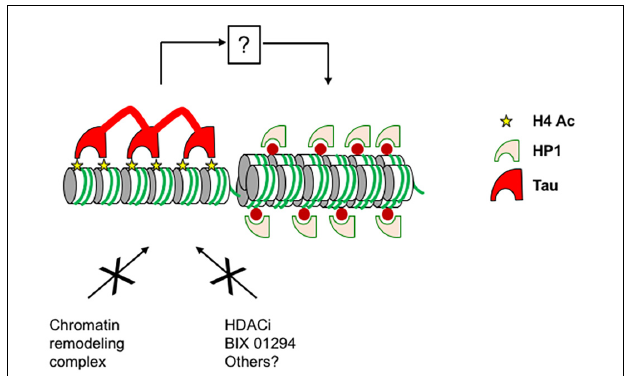
FIGURE 8 | Proposed model for the role of Tau on chromatin. Tau binds to condensed chromatin regions through the interaction with unmodified histone H3, H4, or acetylated H4. The interaction between Tau and histones maintains the condensed chromatin state and prevents chromatin remodeling complexes accessing histones and gene expression. By an indirect mechanism, Tau also prevents heterochromatin decompaction and HP1s spreading induced by chromatin remodeling agents such as TSA, BIX 01294, and possibly